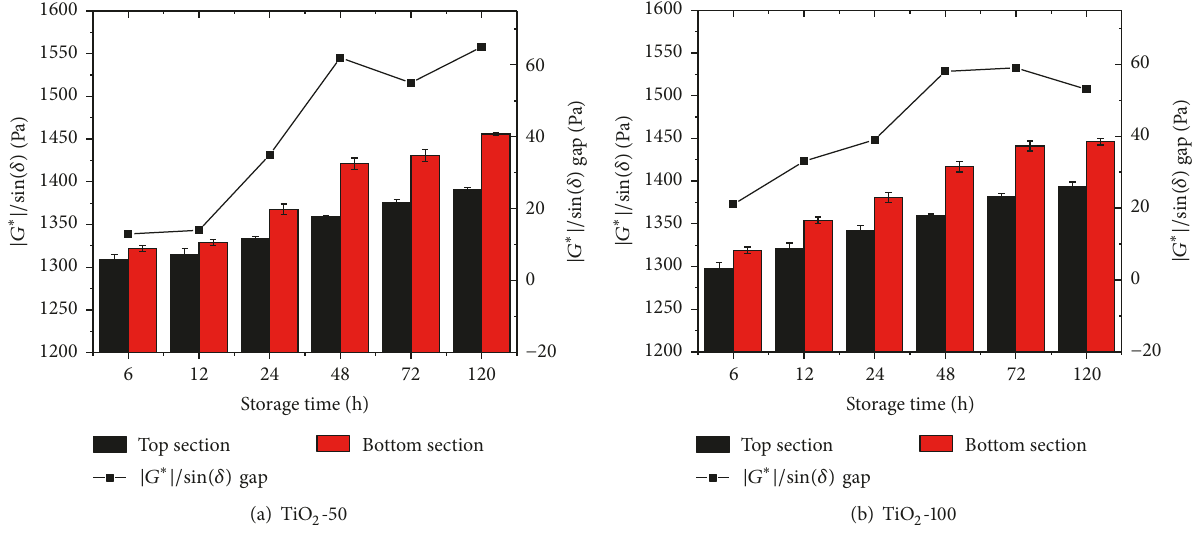
Figure 7: The effects of storage time on |𝐺 ∗ |/ sin (𝛿) .